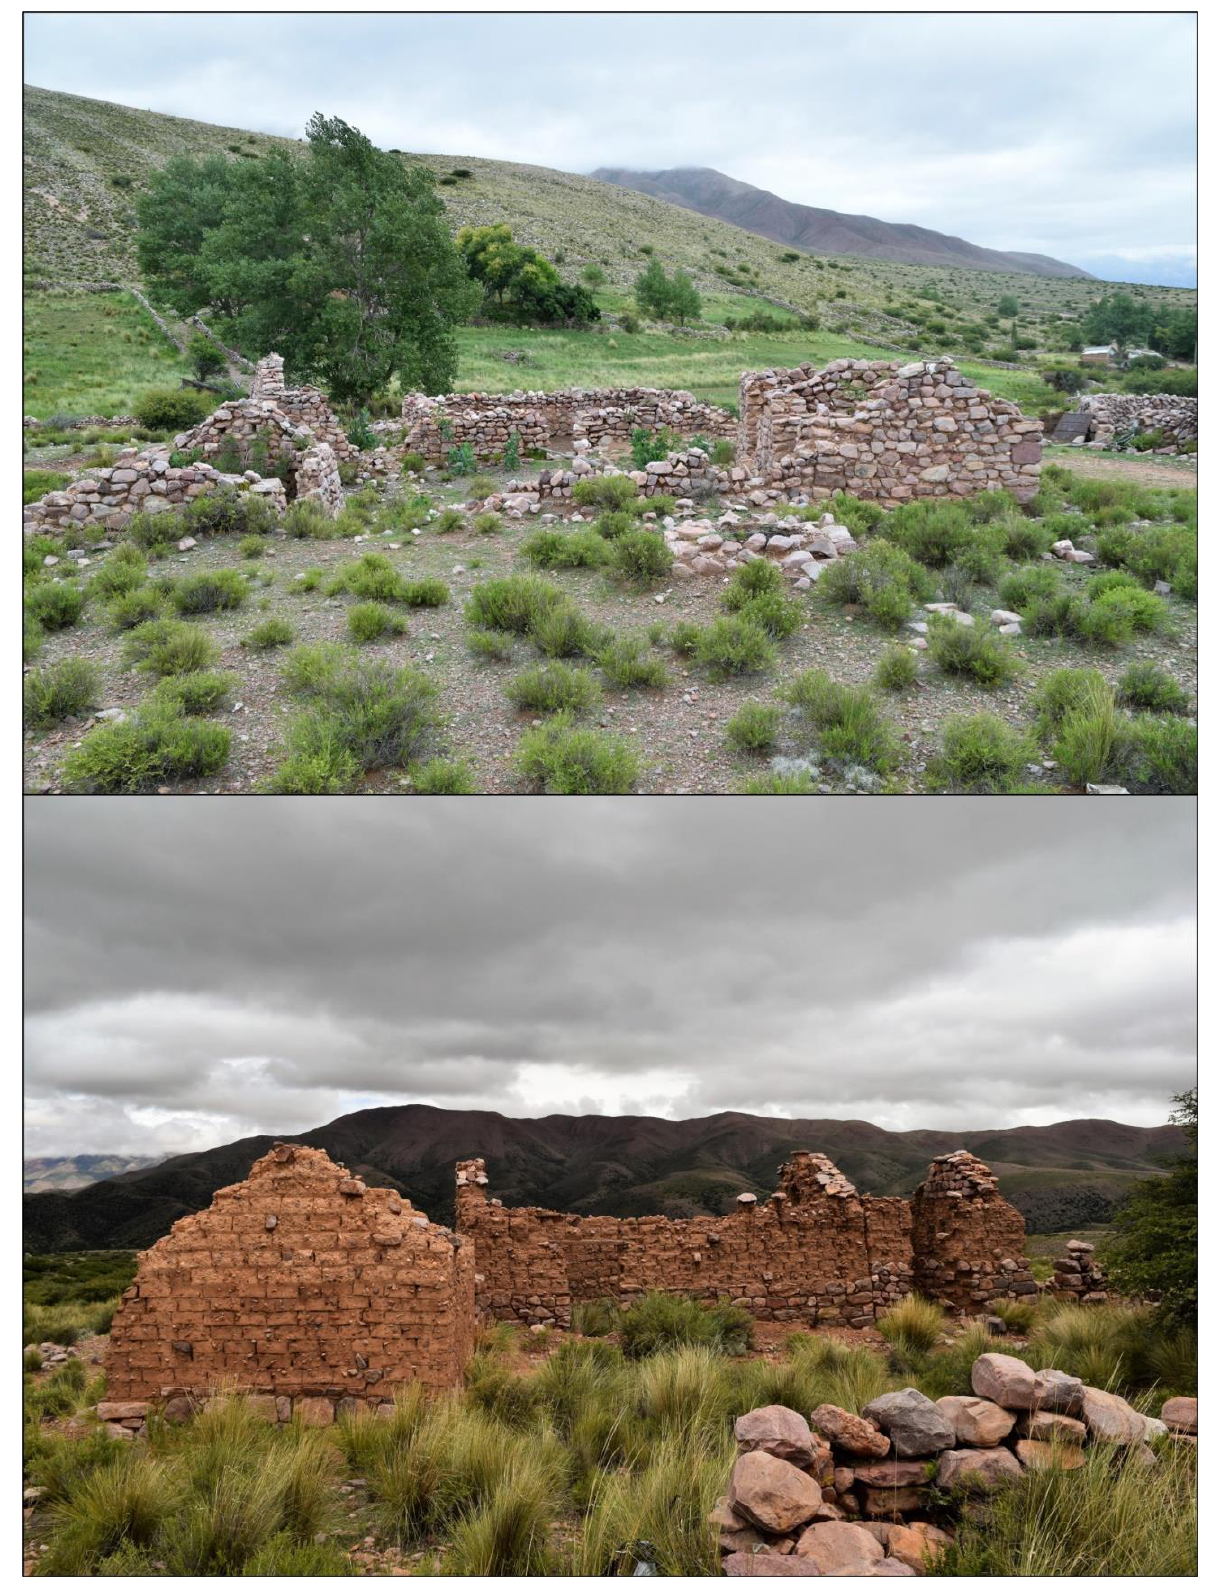
Figure 12. Abandoned houses in Rodero. The house above, built with stone walls, is older than the house below, with adobe walls (photo: Pablo Cruz, CONICET, 2019).